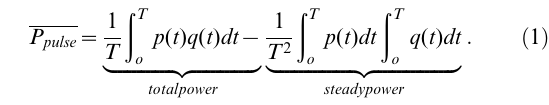
placed at different locations along the aorta as illustrated in Figure 3 (The ring was just a snap grip hose and it was located outside of the aorta). This extra reflection site was used to alter the for 4 seconds and each experiment was repeated 9 times.